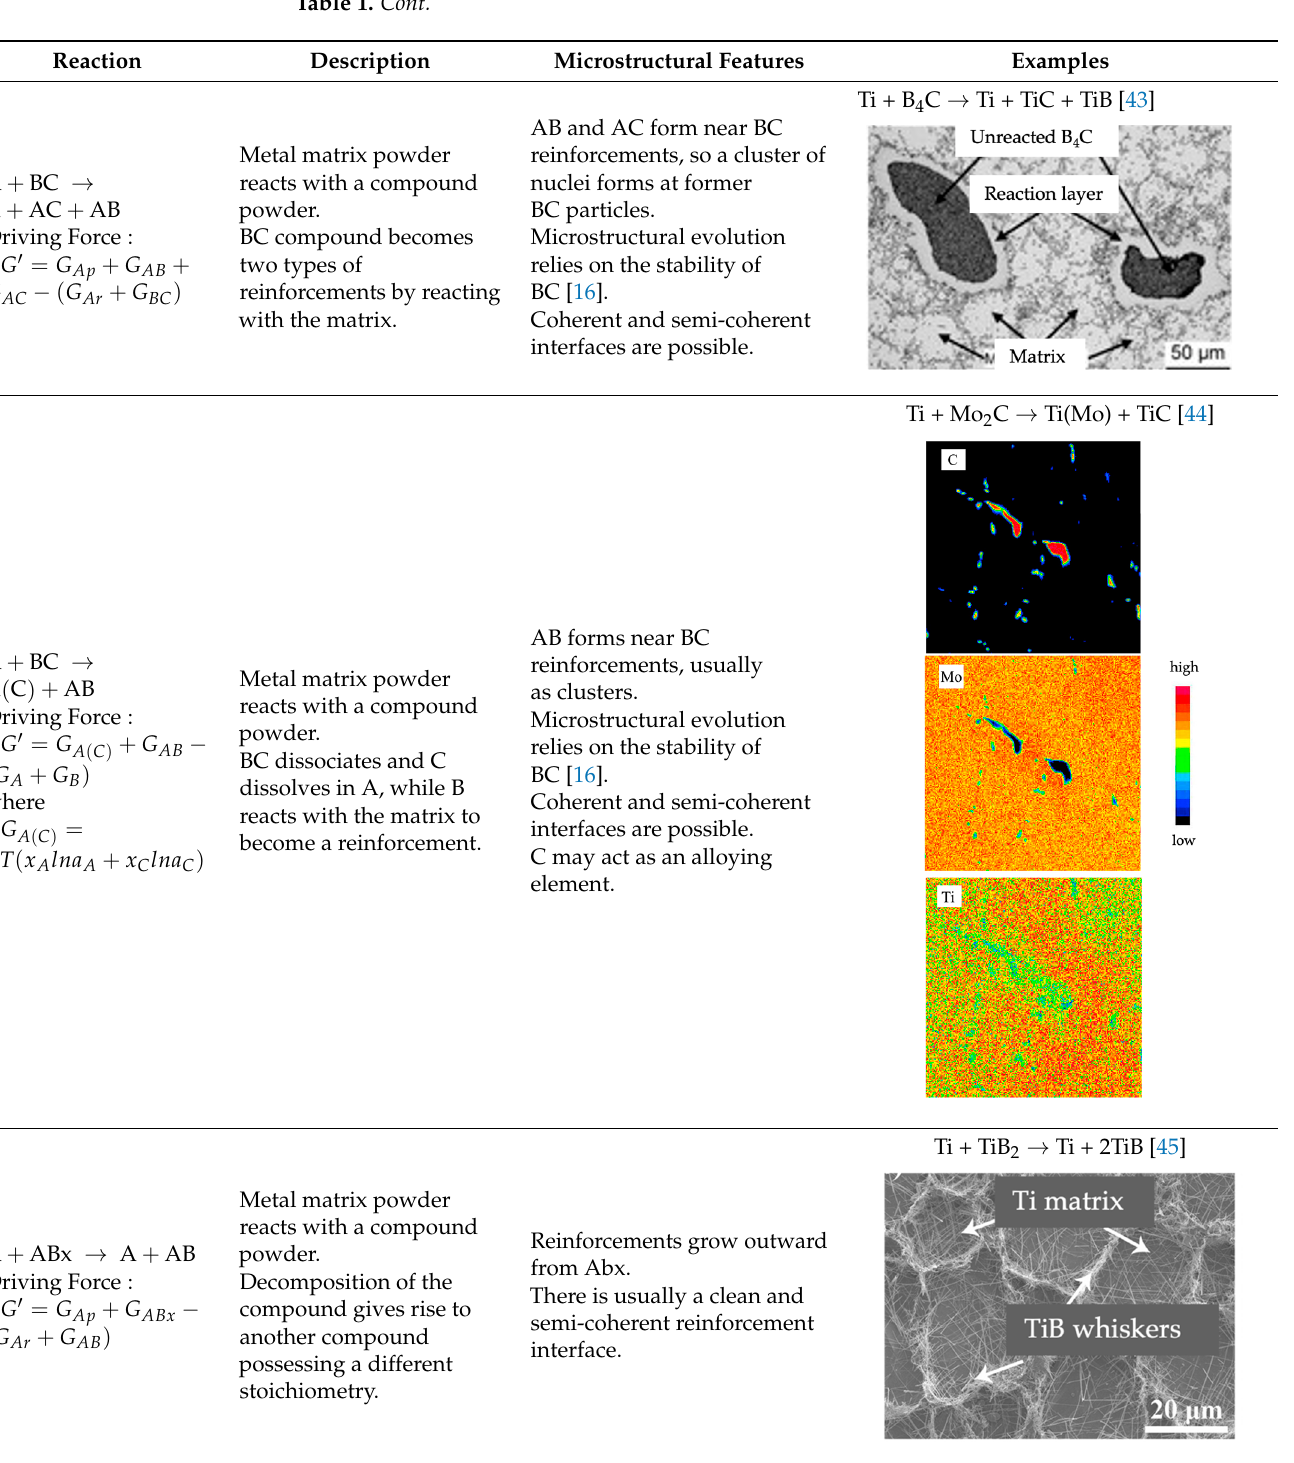
Table 2. Raw material possibilities for composites of type A + BC. Δ G is the Gibbs free energy change